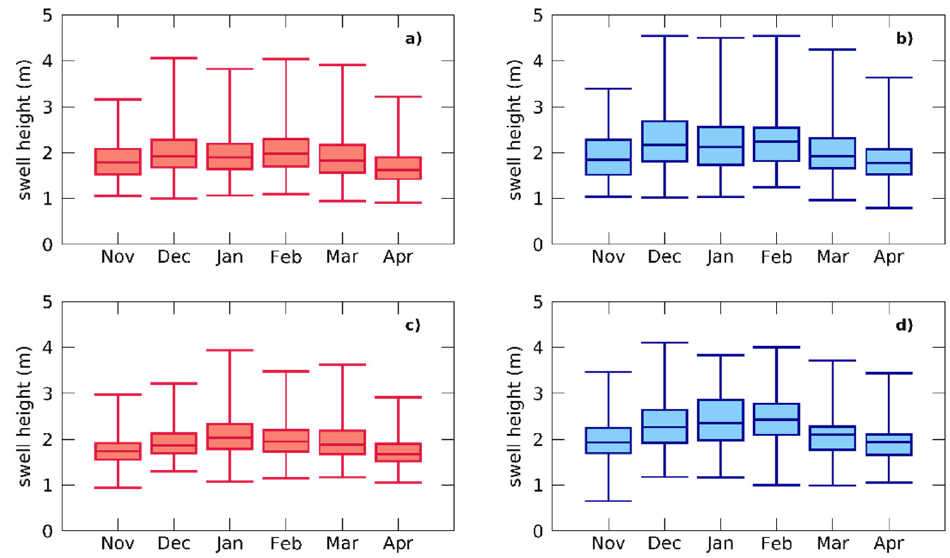
Figure 5. Average monthly swell heights for ( a ) ERA5 at buoy 41044, ( b ) buoy 41044, ( c ) ERA5 at buoy 41040, and ( d ) buoy 41040. Box plots are defined by minimum, lower quartile, median, upper quartile, and maximum.